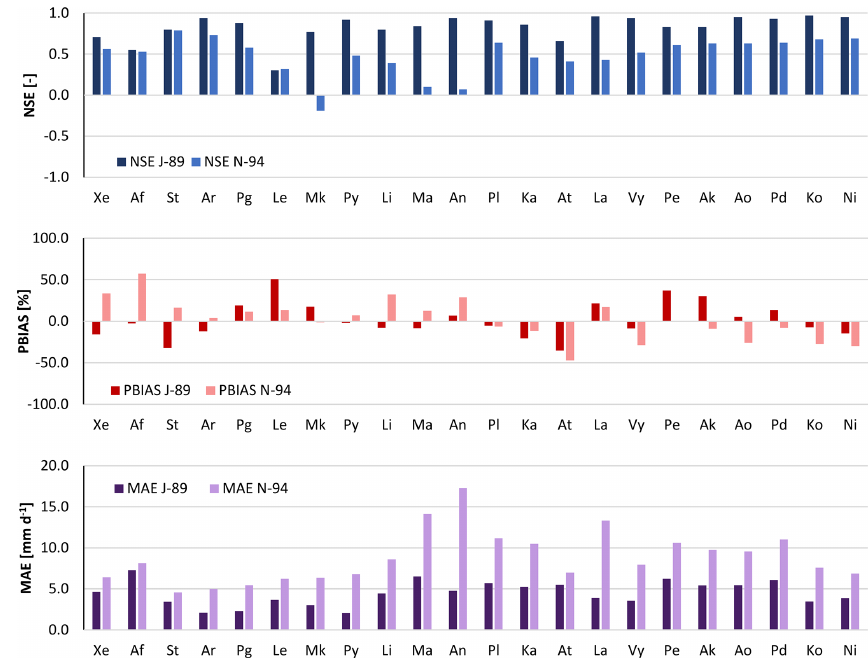
Figure 8. Performance indices (NSE, Nash–Sutcliffe efficiency; BIAS; MAE, mean absolute error) of daily WRF-modelled rainfall over the 22 watersheds for both January 1989 (J-89) and November 1994 (N-94) events. For watershed abbreviations refer to Table